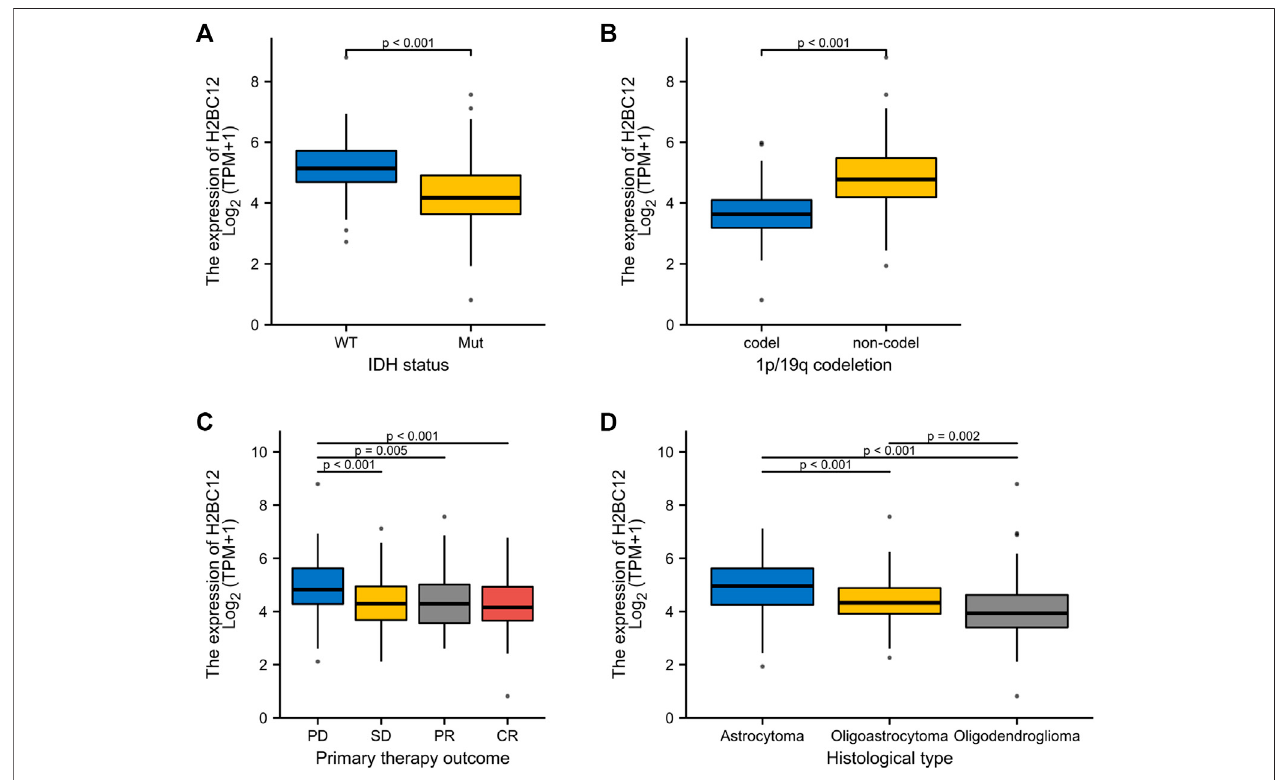
FIGURE 2 | Association between H2BC12 expression and clinicopathologic characteristics. H2BC12 expression correlated signi fi cantly with IDH status (A) , p < 0.001, 1p/19q codeletion (B) , p < 0.001, primary therapy outcome (C) , p < 0.01, and histological type (D) , p <